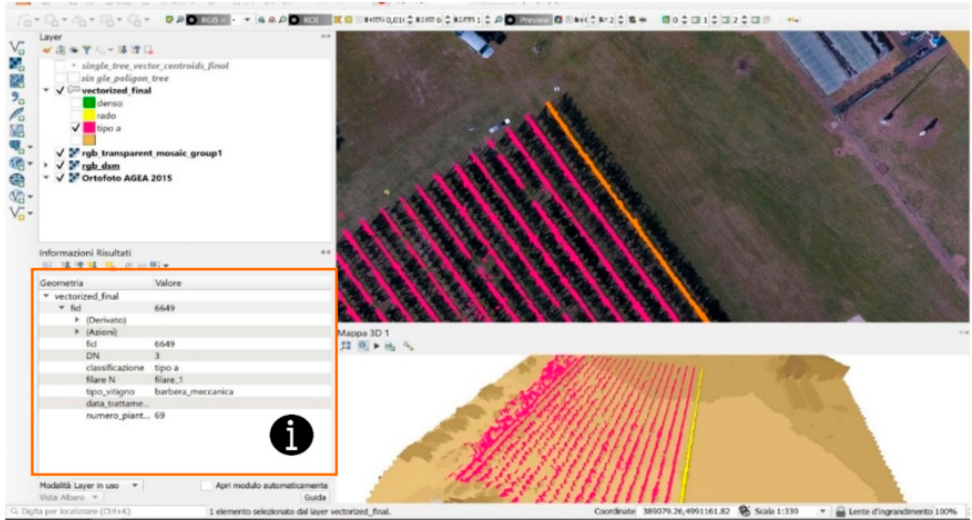
Figure 11. QGIS project with 2D and 3D visualisation and querying of Grugliasco vineyard data.